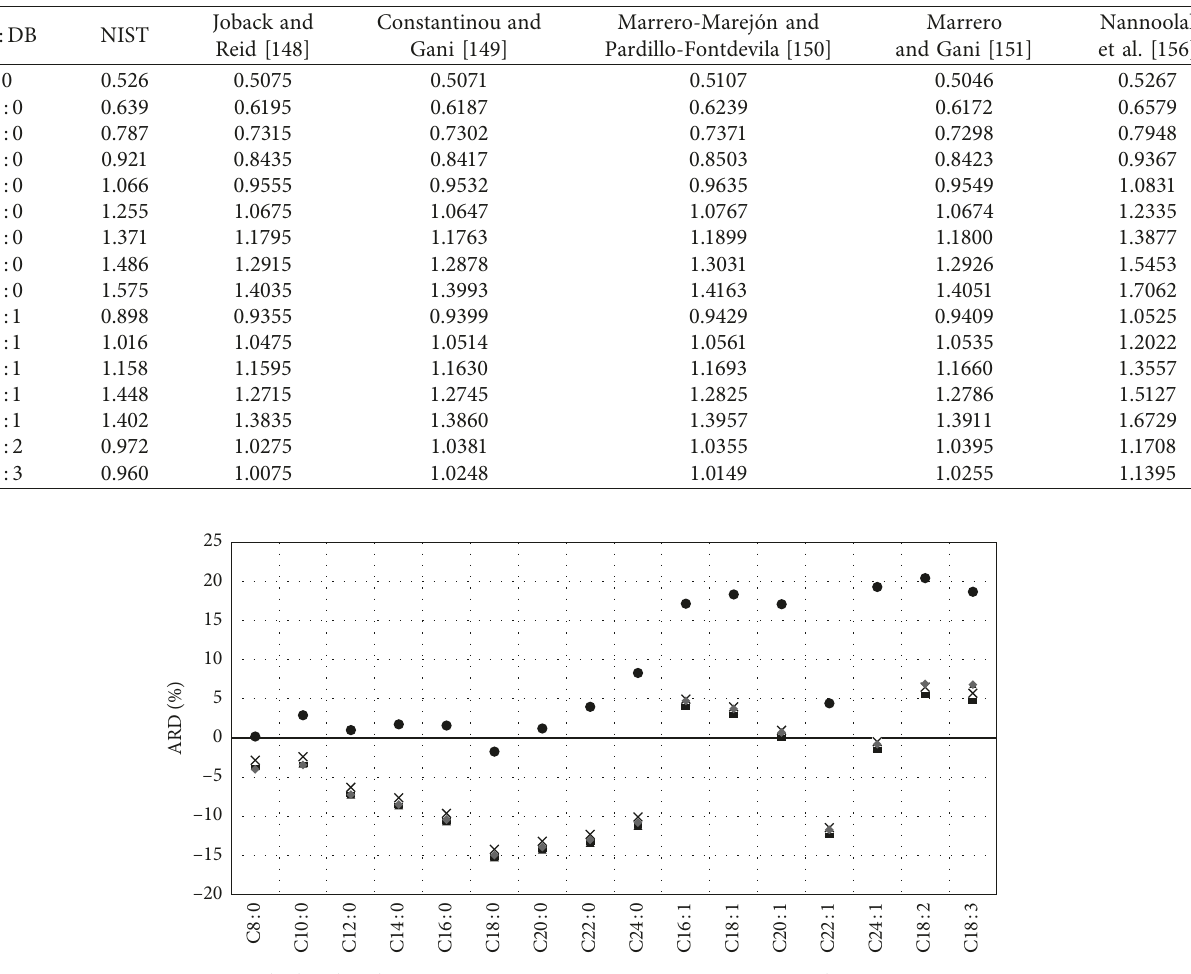
Table 16: Comparison of experimental and estimated critical volume (m 3 /kmol).